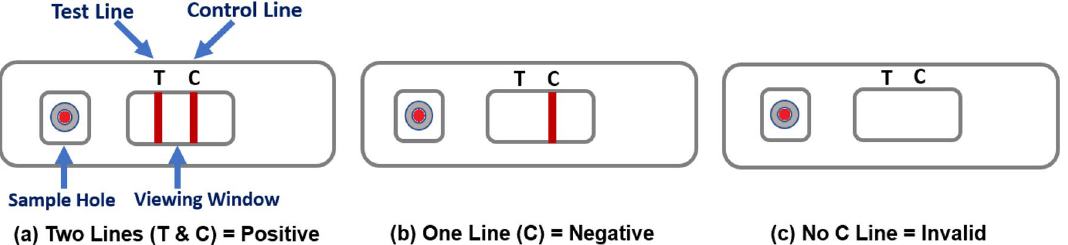
Figure 1. Illustration of the LFIA testing device: ( a ) structure of the testing device showing the sample hole, viewing window with the control line and test line as an example of positive result; ( b ) an example of negative result, and ( c ) example of invalid (without C-line).